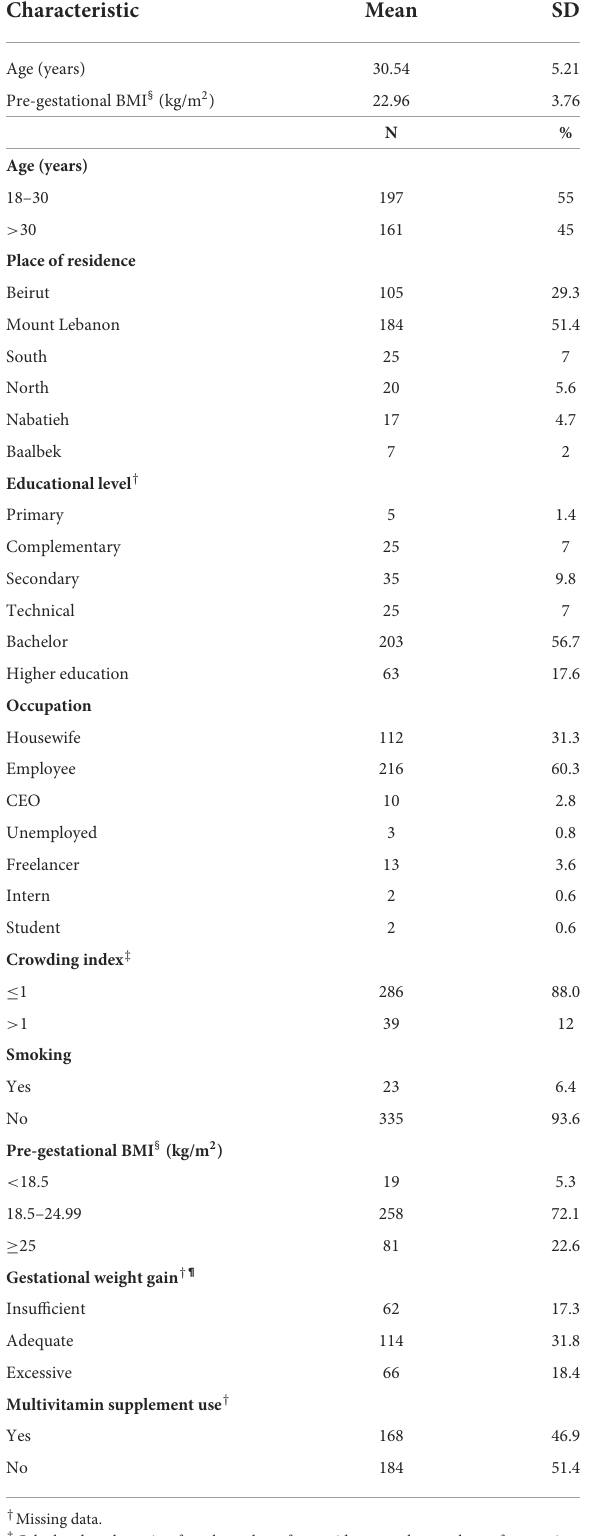
TABLE 1 Descriptive characteristics of the sample (N = 358 †